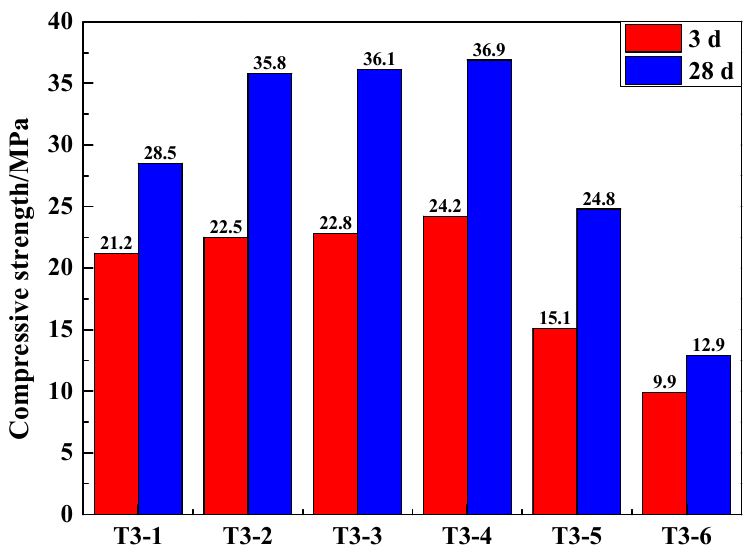
Figure 3. Compressive strength of samples made of SSCND–cement at the ratio of 80:20 activated under different contents of Na 2 SO 4 after 3 and 28 days of curing.